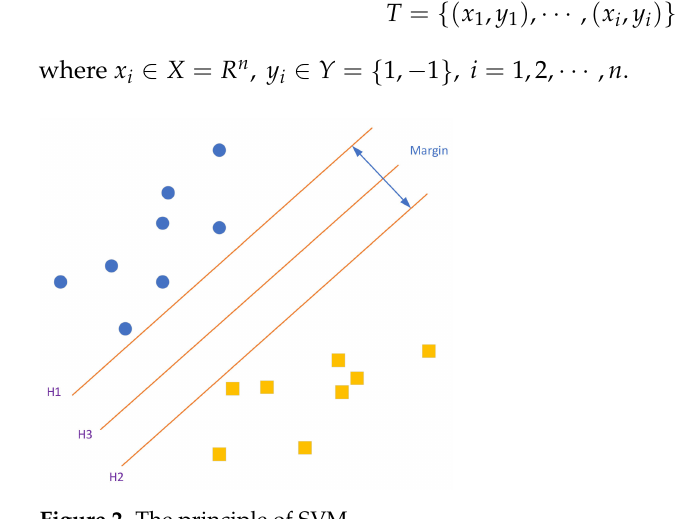
Figure 2. The principle of